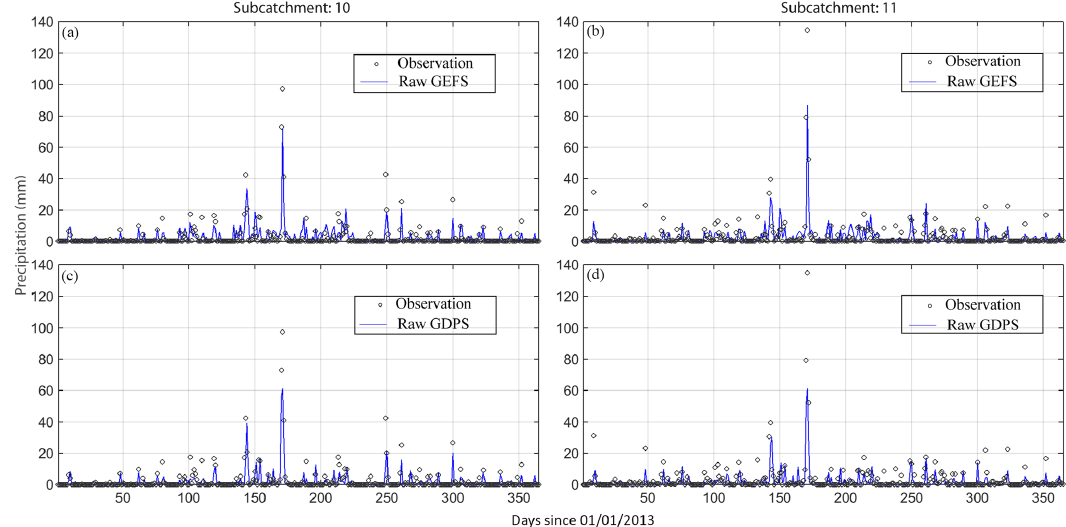
Figure 2. Comparison of weighted-area raw QPFs with subcatchment-averaged observations for the year 2013 in subcatchments 10 and 11. Raw GEFS data are plotted in (a) and (b) , while (c) and (d) show raw GDPS data, along with